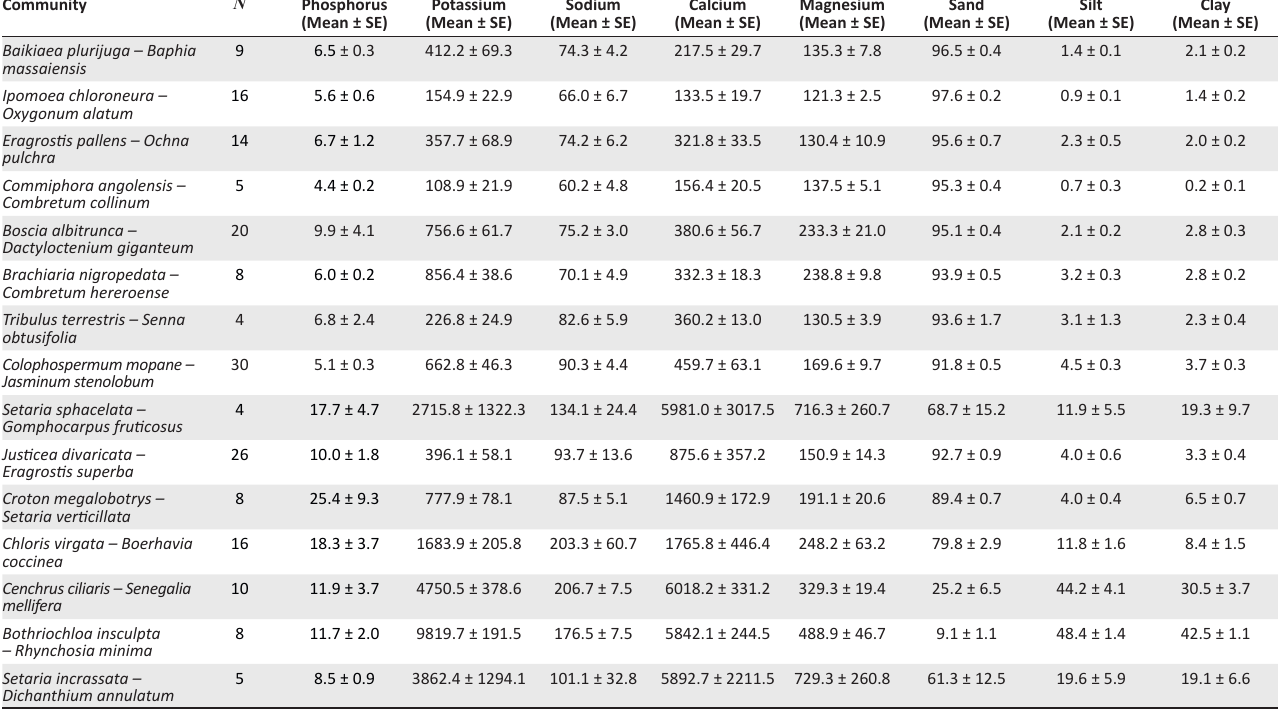
TABLE 1: Soil texture and nutrient characteristics in the Savuti-Mababe-Linyanti ecosystem, northern Botswana. Community